Question: How would you classify this visualization?
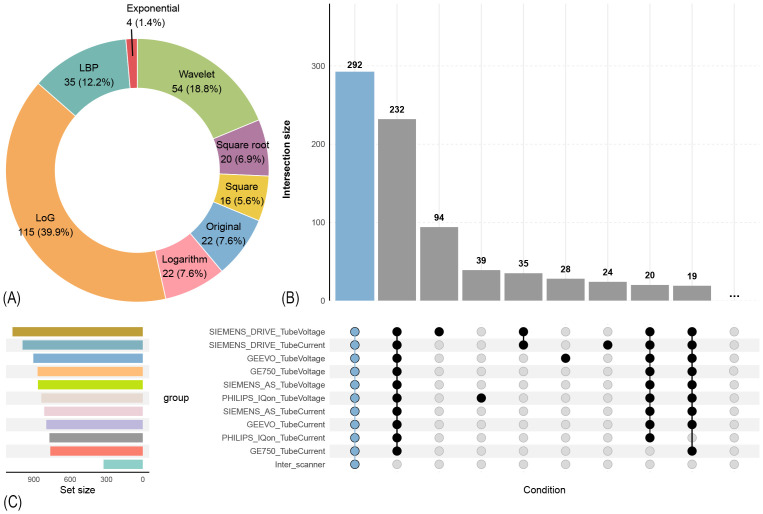
Answer: bar